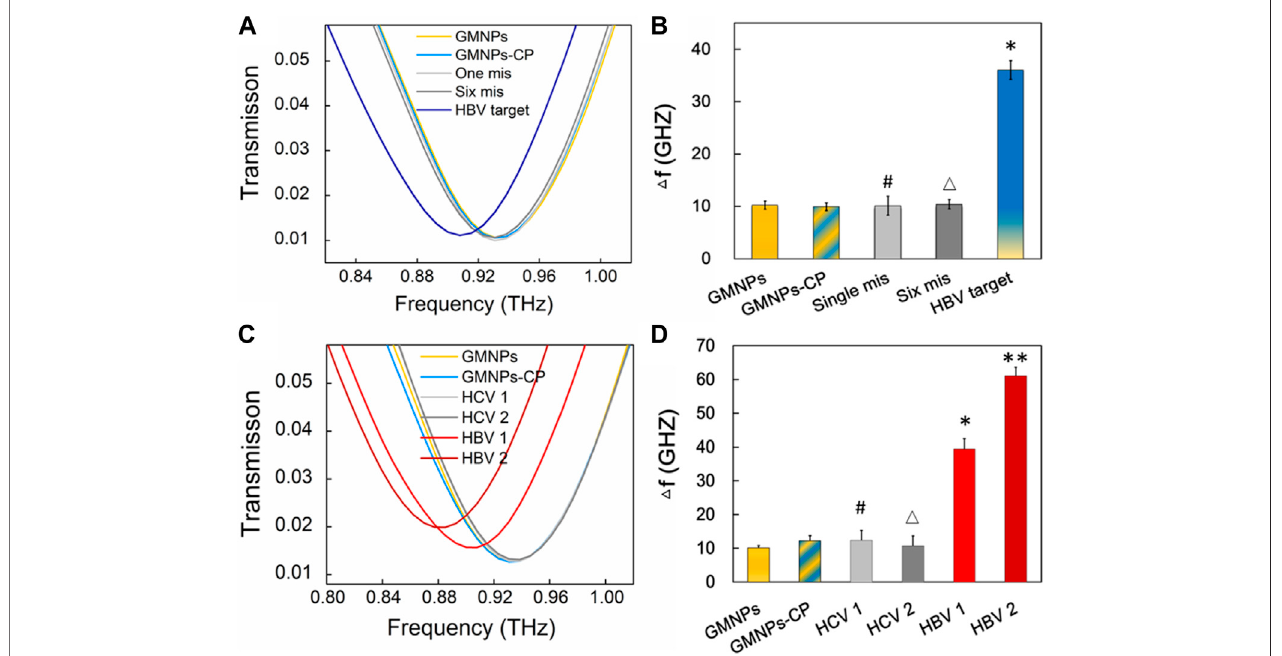
FIGURE6| Speci fi cityveri fi cationoftheTHzbiosensingstrategy. (A) THztransmissionspectraforHBVtargetandmismatchedsequence. (B) Thefrequencyshifts ( Δ f )ofTHztransmissionspectra.ErrorbarsindicatetheSD( n =3).Signi fi cancewasdeterminedusingone-wayANOVA; *p < 0.05,HBVtargetversusGMNPs; # p > 0.05, single-base mismatched sequence versus GMNPs; and △ p > 0.05, six-base mismatched sequence versus GMNPs. (C) THz transmission spectra for HBV and HCV in serum samples. (D) The frequency shifts ( Δ f ) of THz transmission spectra. Error bars indicate the SD ( n = 3). Signi fi cance was determined using one-way ANOVA, *p < 0.05,HBV1(1.74E+03 IU/ml)versusGMNPs, **p < 0.05,HBV2(1.58E+06 IU/ml)versusGMNPs, # p > 0.05,HCV1(4.03E+03 IU/ml)versusGMNPs,and △ p >